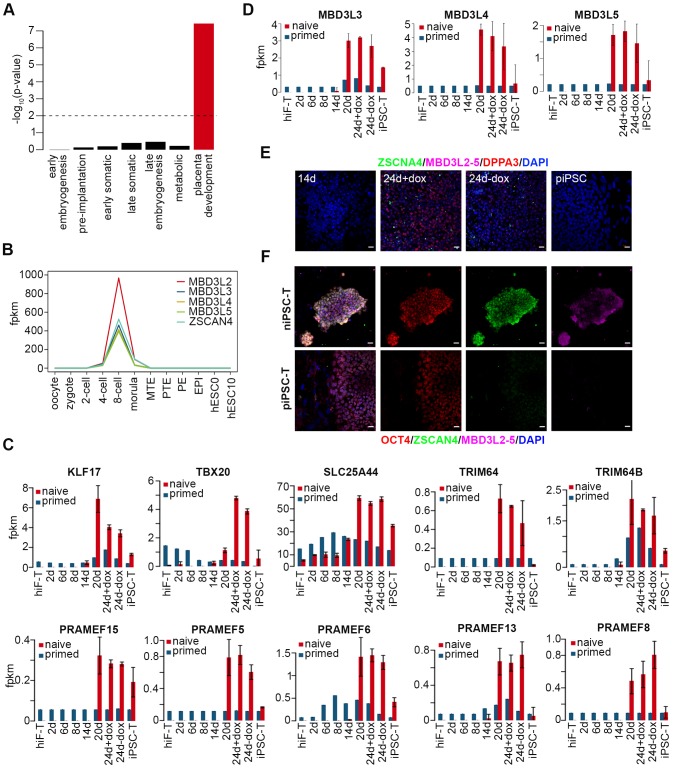
Dynamics of 8C-genes during naïve reprogramming.(A) Bar plot showing the p-value of 8C-gene enrichments in each cluster measuring with Fisher’ exact test. (B) Line plot showing expression patterns of selected genes during human pre-implantation development. (C) Bar plot showing the absolute expression values of several 8C-genes in the naïve and primed reprogramming processes. Error bars represent a 95% confidence interval around the mean value. (D) Bar plot showing the absolute expression values of MBD3L3/4/5 genes in the naïve and primed reprogramming processes. Error bars represent a 95% confidence interval around the mean value. (E) Immunostaining images of ZSCAN4, MBD3L2-5 and DPPA3 expression in cells during primed reprogramming. Scale bar, 50 μm. (F) Immunostaining for OCT4, ZSCAN4 and MBD3L2-5 in niPSC-Ts and piPSCTs respectively. Scale bar, 20 μm.